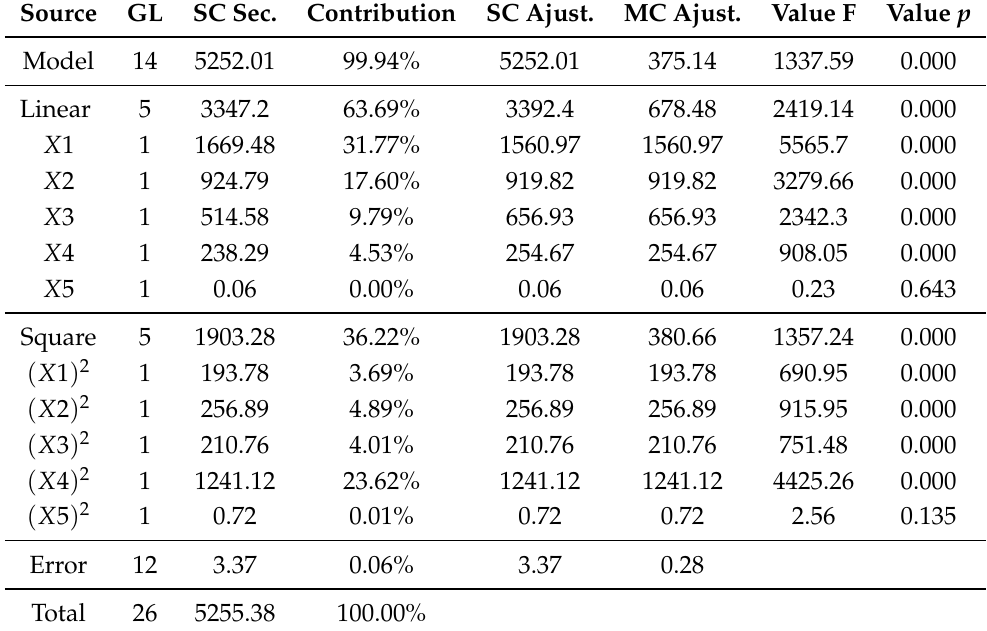
Table 4. Analysis of variance